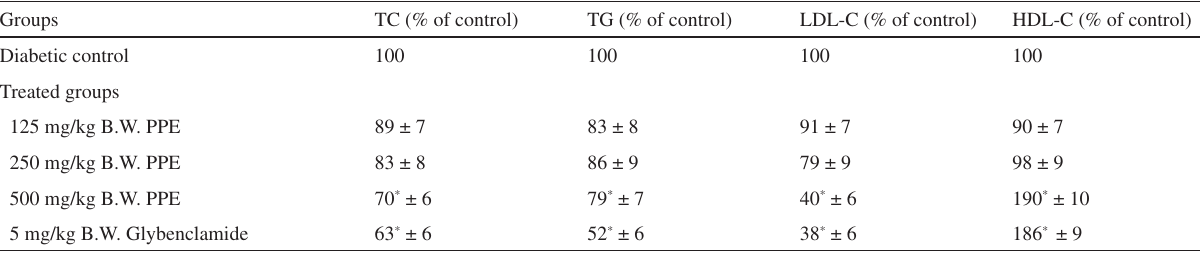
Table 3 - Effect of PPE on serum lipid profiles of STZ-induced diabetic rats. Groups